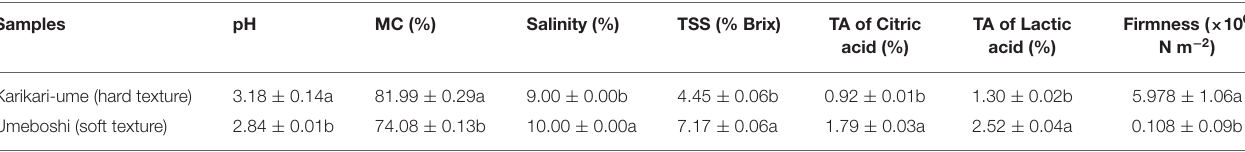
TABLE 1 | Physicochemical parameters of two types of salted Japanese apricot pickles. Samples